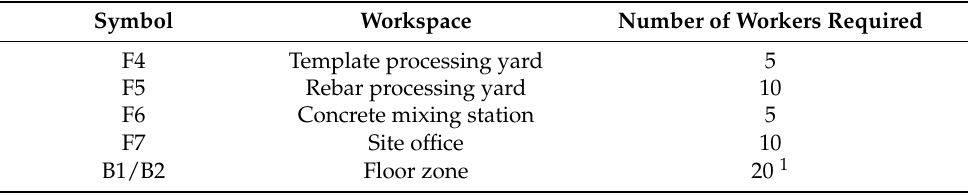
Table 2. Number of workers at the corresponding